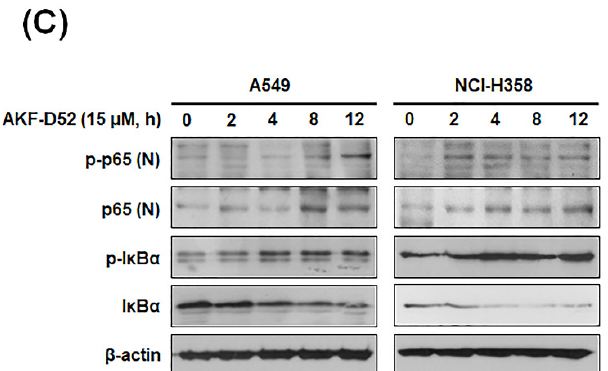
Figure 4. The effects of AKF-D52 on activation of the extrinsic pathway in NSCLC cells. A549 and NCI-H358 cells were treated with 15 μ M AKF-D52 for different lengths of time (0, 2, 4, 8, or 12 h). ( A ) Cells were lysed, and Western blot analysis was performed, as described in the Materials and